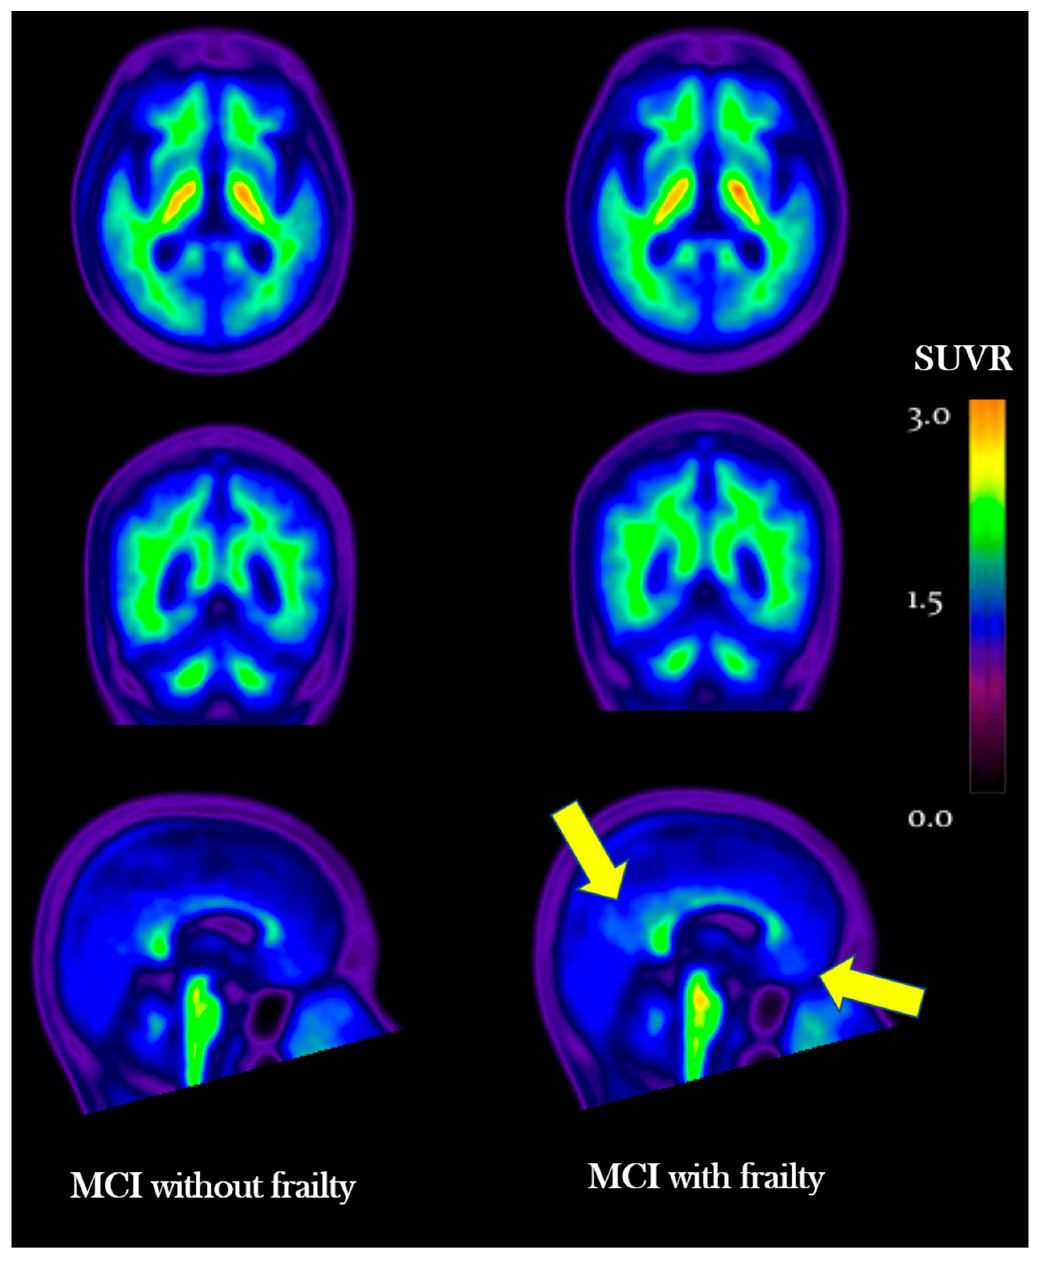
Figure A2. Representative images of 11 C-PiB-PET for cerebral amyloid burden of the same MCI and the cognitive frailty patients. Images scaled to the same SUVR are shown. Left row: negative amyloid scan; right row: positive amyloid scan. SUVR = standard uptake value ratio.